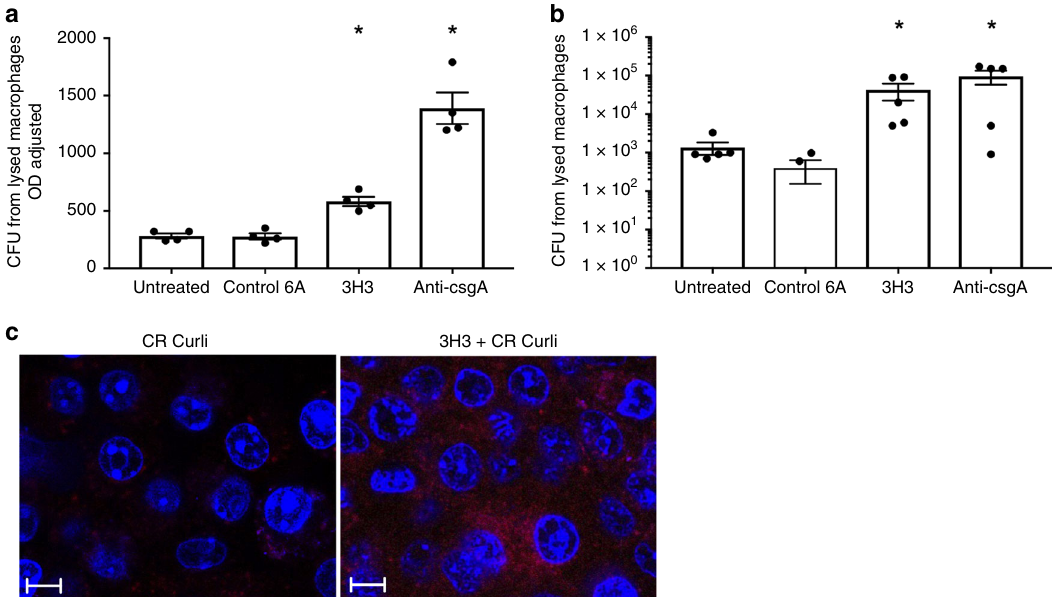
Fig. 6 Treatment with monoclonal antibody 3H3 enhances uptake of bacteria by macrophages. a Wild-type bone marrow derived macrophages (BMDMs) were treated with 100 μ l supernatants from bio fi lms grown in the absence (untreated) or presence of 0.5 mg/ml 3H3. After 1 h, gentamicin was added, cells were lysed, and bacteria were enumerated as colony forming units. b Wild-type BMDMs were treated with supernatants from bio fi lms grown in the absence (untreated) or presence of 0.5 mg/ml 3H3 adjusted to an optical density of 0.5 at 600. After 1 h, gentamicin was added, cells were lysed, and bacteria were enumerated as colony forming units. c 1 × 10 6 wild-type immortalized macrophages were stimulated with 5 μ g of untreated curli (CR Curli) or 3H3 incubated curli (3H3 CR Curli) for 1 h at 37 C and 5% CO 2. Cells were washed 3× with PBS to remove excess curli and macrophages were stained with DAPI (blue). Internalization of the curli (red) was imaged using a Leica TCS confocal microscopy at ×63. Scale bars represent 25 μ m. Mean and SE were calculated from results from at least three independent experiments. * p < 0.05, ** p < 0.01 as determined by Student ’ s t